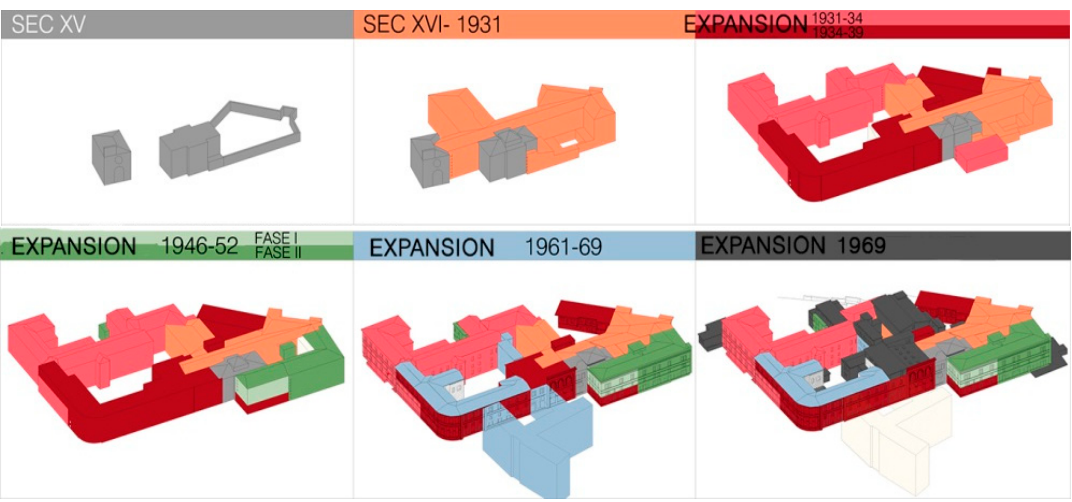
Figure 5. Axonometric view of the historical evolution of the former hospital complex [12].